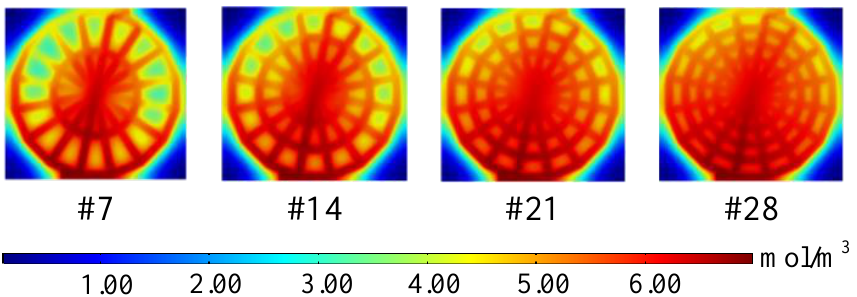
Figure 7. The oxygen distribution of schemes #1, #14, #21 and #28 at the interface of the cathode GDL and CL.